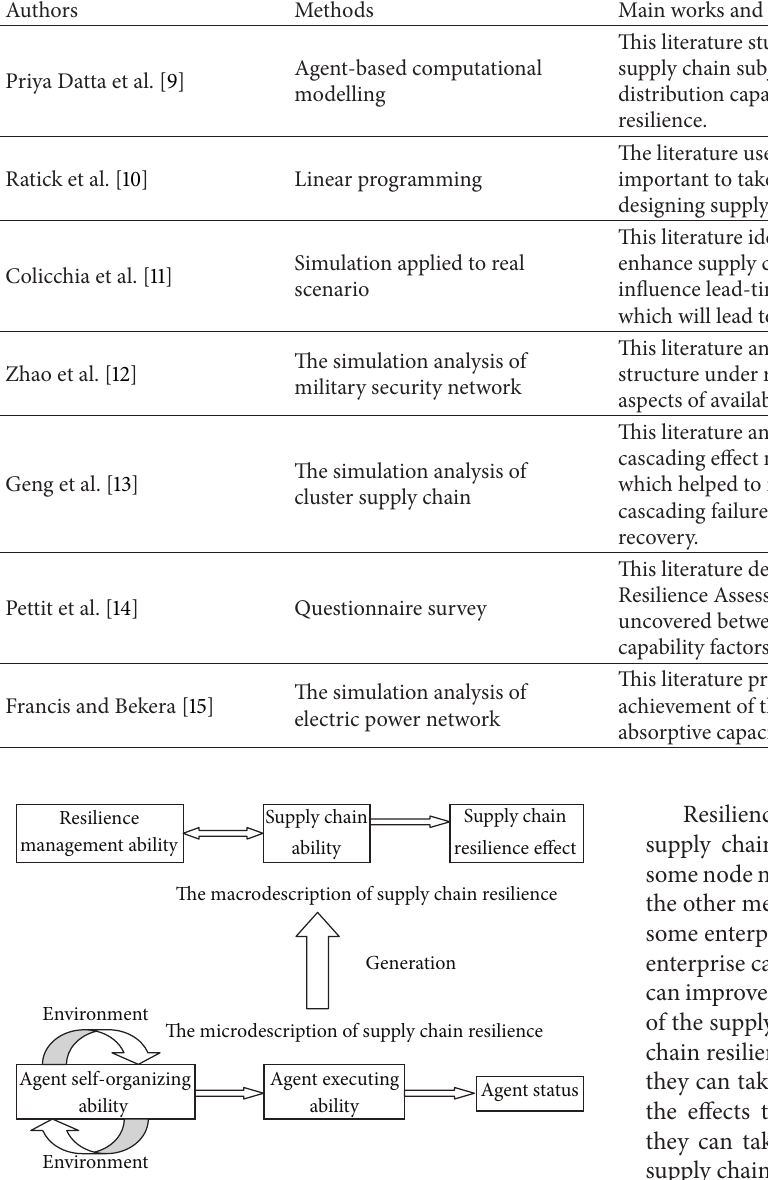
Figure 1: Micro- and macrodescription of supply chain